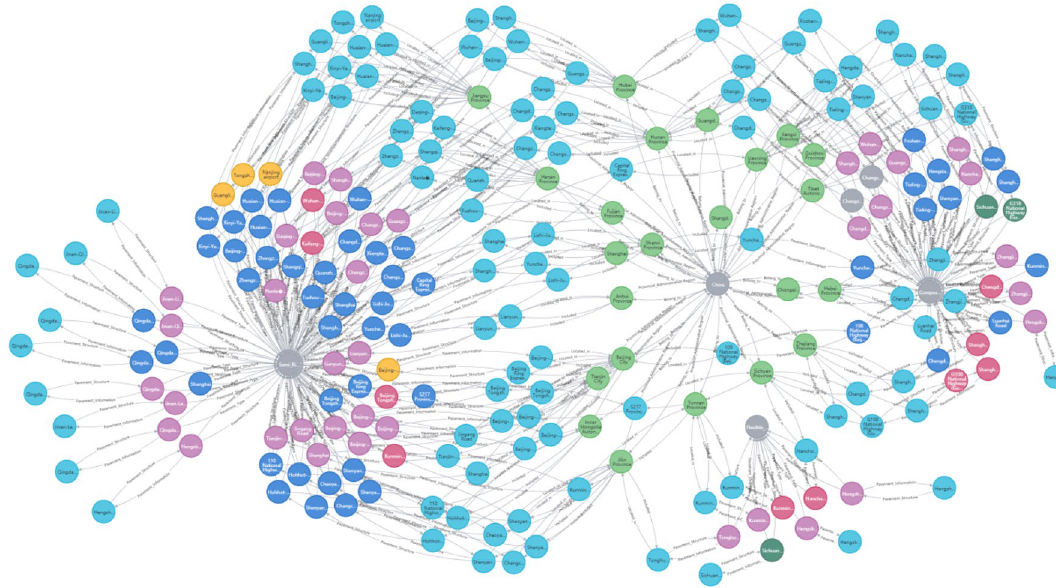
Figure 5. The knowledge graph of pavement